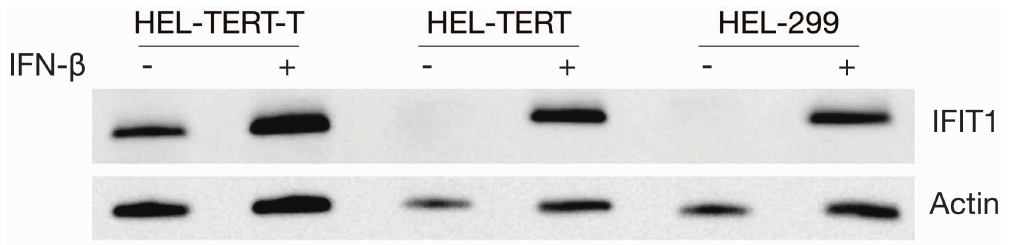
Figure 5. IFIT1 protein production is induced to similar levels by IFN- b in HEL-299 and HEL-TERT cells. HEL-299, HEL-TERT, and HEL- TERT-T cells were mock treated or treated with 1000 U/mL of IFN- b and harvested 9 hours later. Cell lysates were analyzed for IFIT1 or b -actin protein